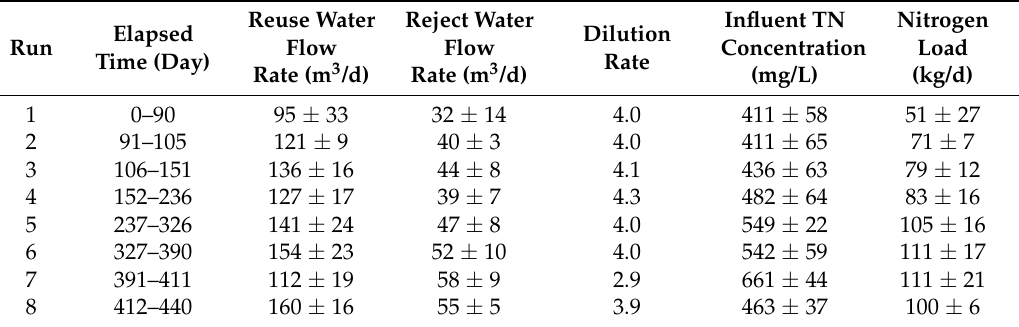
Table 1. Operational